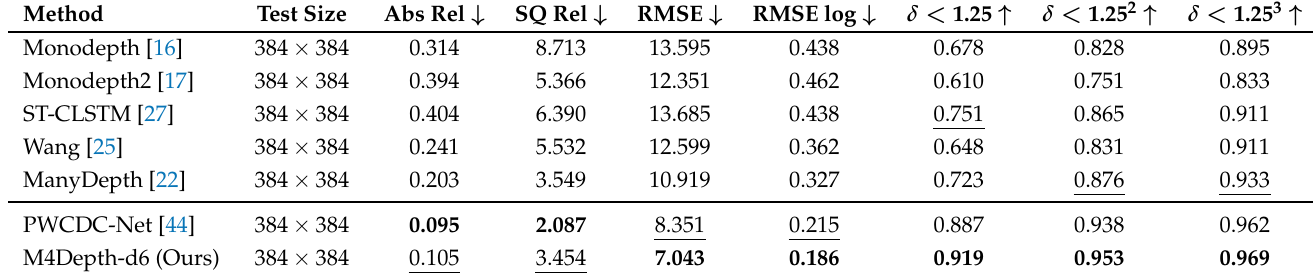
Table 2. Performance comparison on our test set of Mid-Air. Here, a 6-level version of M4Depth is compared to the baseline methods. Scores correspond to the best performance obtained out of five individual network trainings. The best score for a metric is highlighted in bold and the second best is underlined. The four first metrics need to be minimized ( ↓ ) and the three last ones need to be maximized ( ↑ ).